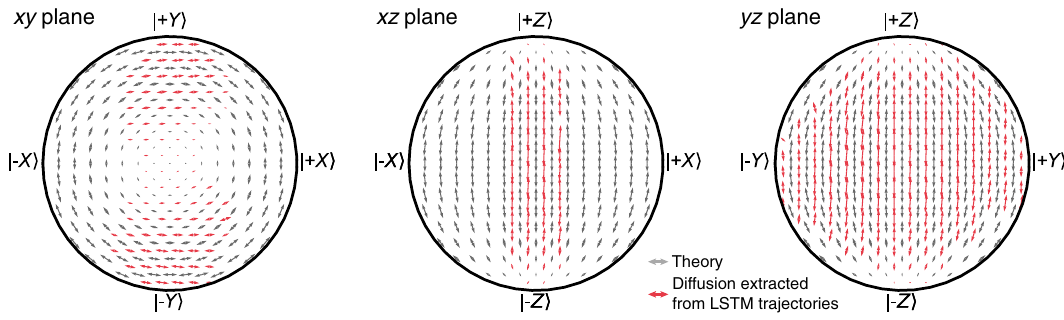
FIG. 11. Comparison between theoretical heterodyne measurement backaction (gray quiver maps) and reconstructed measurement backaction by the LSTM (red quiver maps) for an undriven qubit initially prepared in j (cid:2) Y i . The theory is obtained by setting z , y , x ¼ 0 in the measurement backaction term of Eqs. (E1) – (E3) for backaction in the xy , xz , and yz plane, respectively. The reconstructed quiver maps do not cover the full xy and xz plane due to the limited measurement efficiency η but agree qualitatively with the